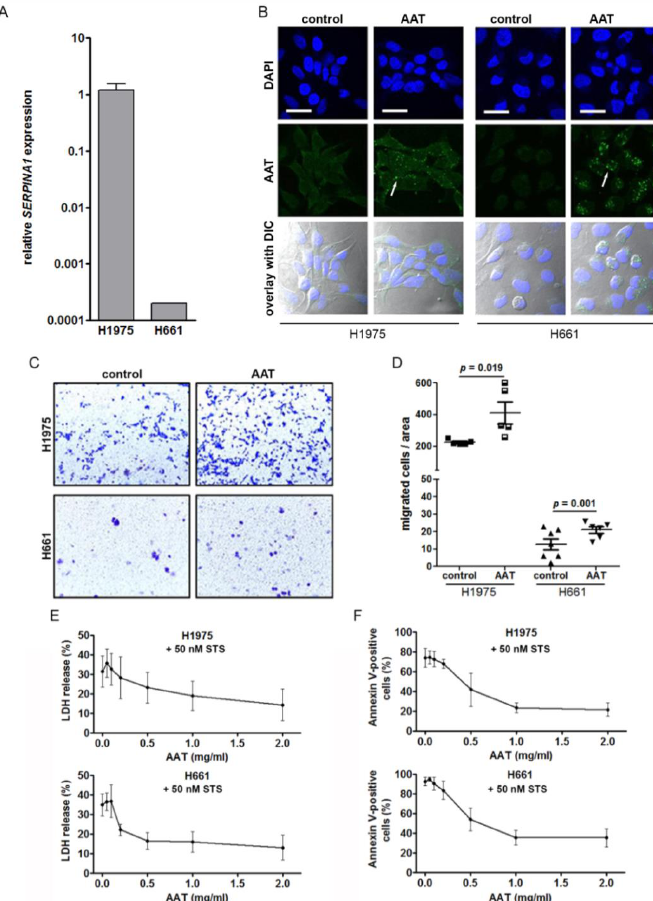
Figure 5. Exogenously added AAT induces cancer cell migration, increases viability and resistance against staurosporine-induced apoptosis. ( A) SERPINA1 expression relative to housekeeping gene POLR2A in H1975 and H661 cell lines. Data presented as the mean ± SD from three independent measurements. ( B) Confocal immunofluorescence staining images of AAT protein (green) in H1975 and H661 in control and AAT (2 mg/mL) treated cells for 18 hours in serum-free medium. Nuclei were defined by DAPI (blue). Scale bar: 30 µm. ( C) and ( D) Migratory properties of H1975 and H661 cells without and with pre-treatment of AAT (2 mg/mL). The migrated cells were stained with 0.1% crystal violet. The graphs indicate data from three independent experiments as mean ± SD. p < 0.05 was considered as significant. ( E ) H1975 and H661 cells were treated with 50 nM staurosporine (STS) alone or together with AAT (0.05 – 2 mg/mL) for 18 hours and lactate dehydrogenase (LDH) release was measured. Each point is a mean ± SD from six independent experiments. ( F ) H1975 and H661 cells were treated with 50 nM STS alone or together with AAT (0.05 – 2 mg/mL) for 18 hours. Annexin V surface expression was determined by flow cytometry. Experiments were repeated four times. Each point represents a mean ± SD. p < 0.05 was considered as significant.